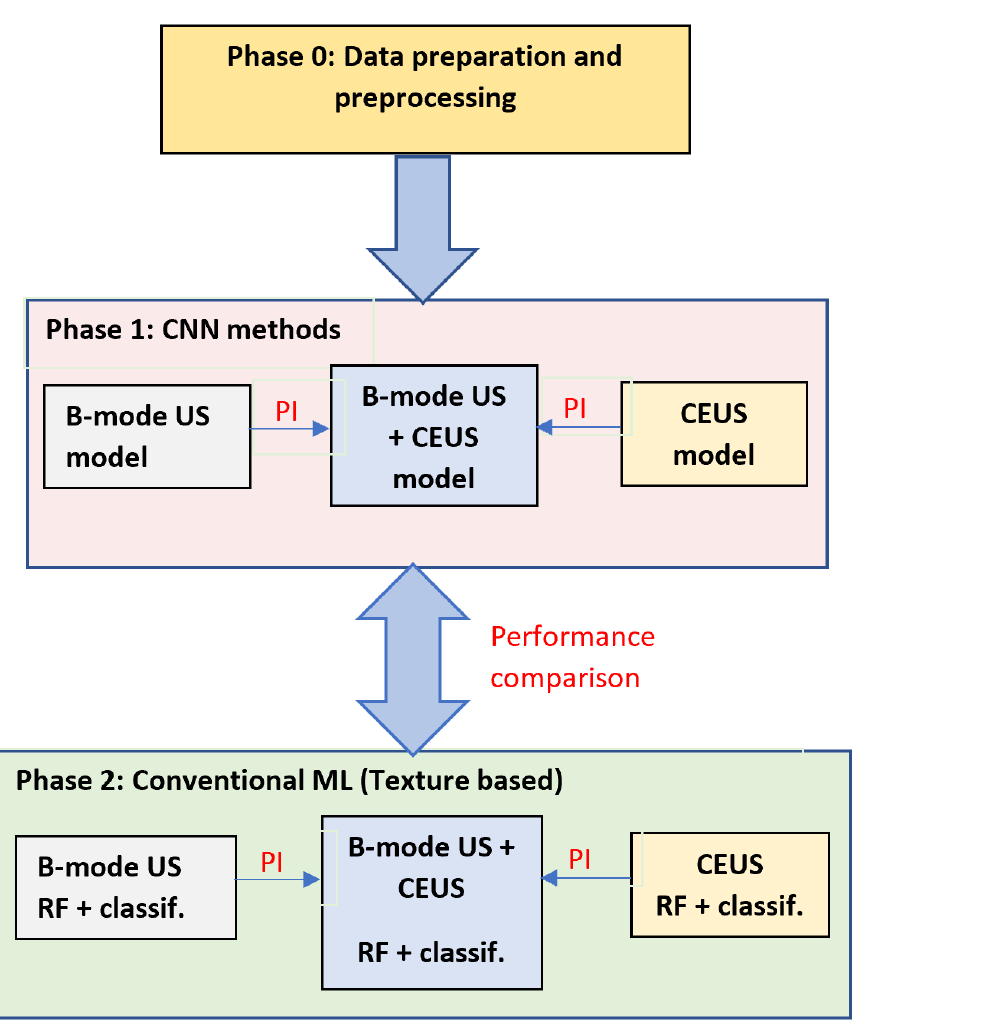
Figure 2. Methodology description. Phase 0 corresponds to data preparation and preprocessing. Phase 1 assumes the assessment of the CNN-based classifiers, on B-mode US and CEUS image separately, respectively on combined B-mode US and CEUS images, estimating the Performance Improvement (PI) for the last case. Phase 2 consists of assessing a conventional Machine Learning (ML) approach, based on advanced texture analysis and traditional classifiers and comparing the corresponding performance with that obtained during Phase